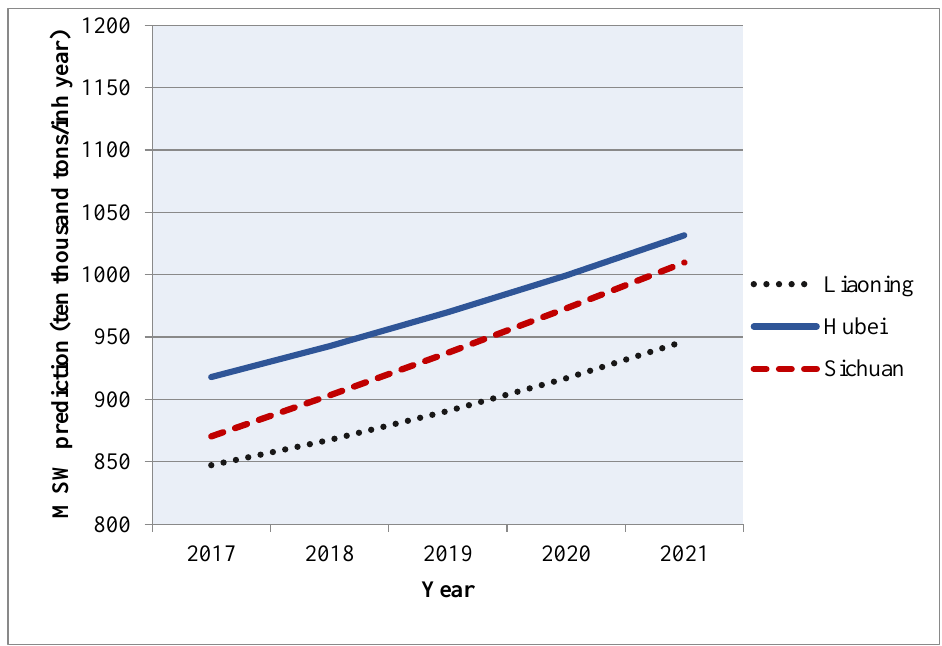
Figure 4. Forecasting results of MSW generation in three provinces during 2017–2021.